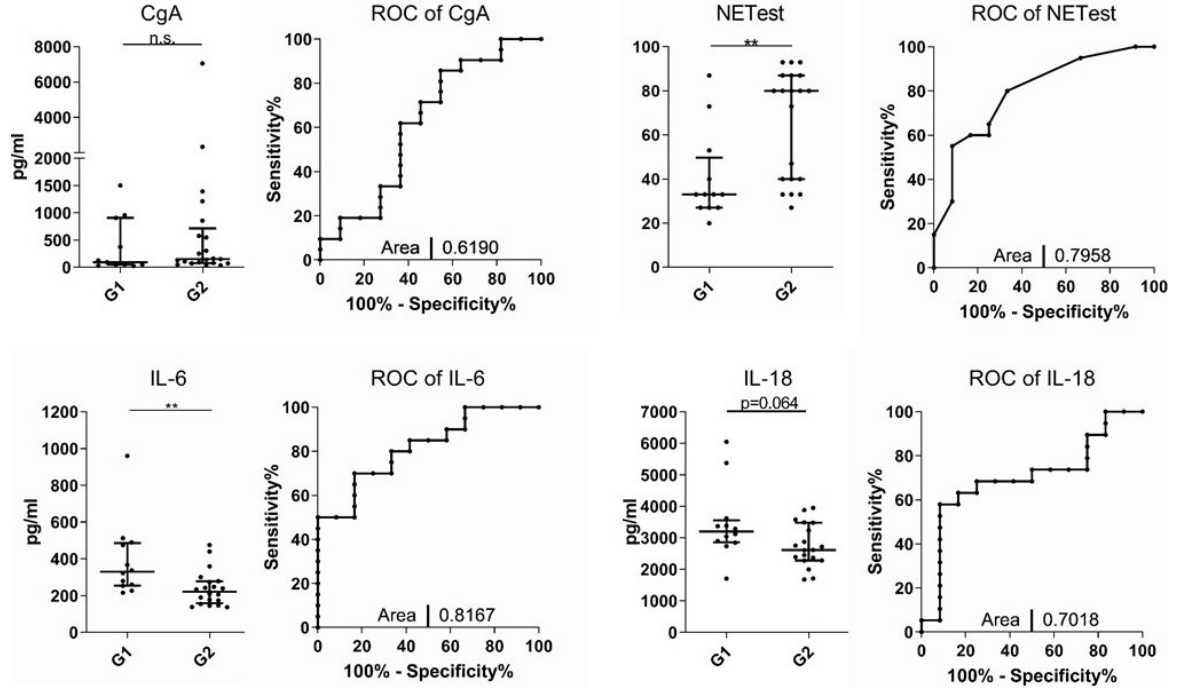
Figure 2 . IL-6 serum cytokine levels indicate a difference between Grade 1 and 2 tumors . Analysis of serum cytokines between patients with G1/G2 NETs at the beginning of the study (baseline; BL). Receiver-operating characteristic (ROC)/area under the curve to indicate that all evaluated cytokines allow a discrimination between G1 and G2 tumors (** p < 0.01). Horizontal bars indicate median and IQR; AUC was automatically calculated using GraphPad Prism.